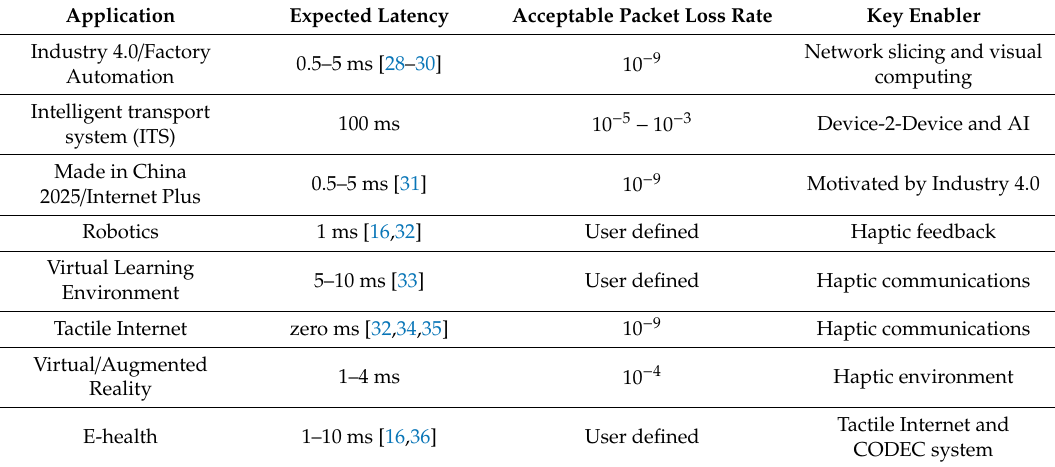
Figure 3. The system architecture of the current wireless network. Table 2. Highlights of potential 5G applications and their requirements of ultra-low